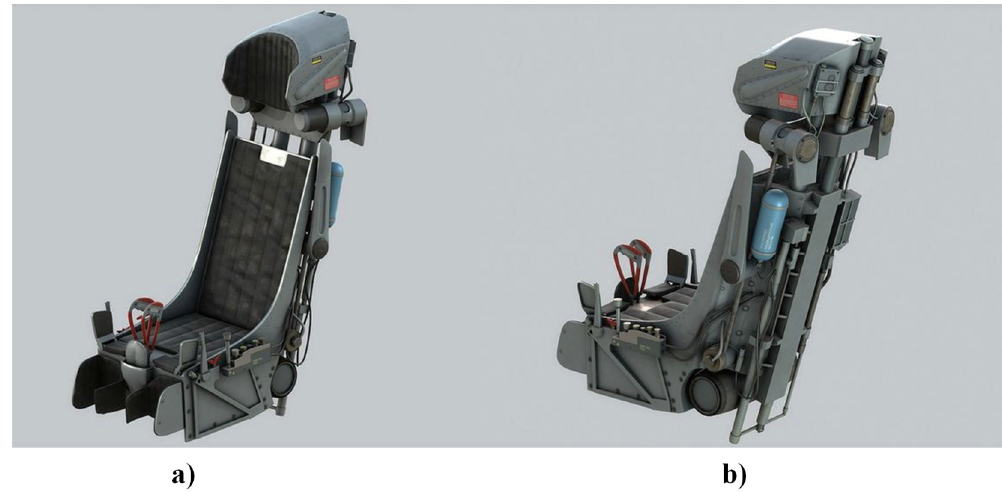
Figure 1. Fourth-generation k-39 ejection seat. ( a ) Front view; ( b ) rear view.